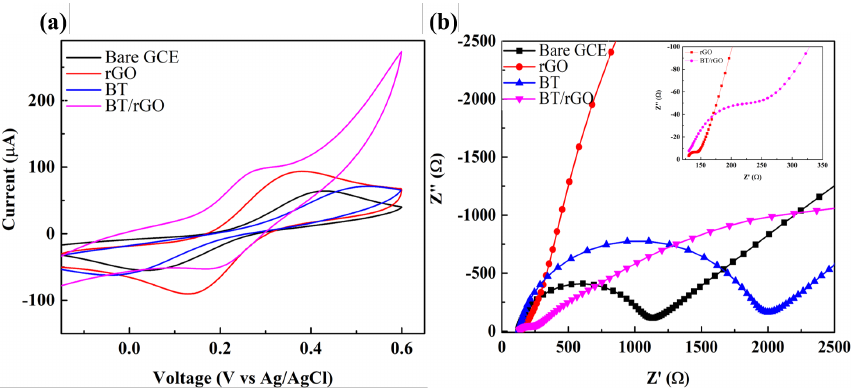
Figure 5. ( a ) CV and ( b ) Nyquist plots of bare GCE, GO, BT, and BT/rGO in KCl (0.1 M) with [Fe(CN) 6 ] 3–/4– (5 mM). The inset in ( b ) shows an expanded view of EIS profiles of the rGO- and BT/rGO-modified